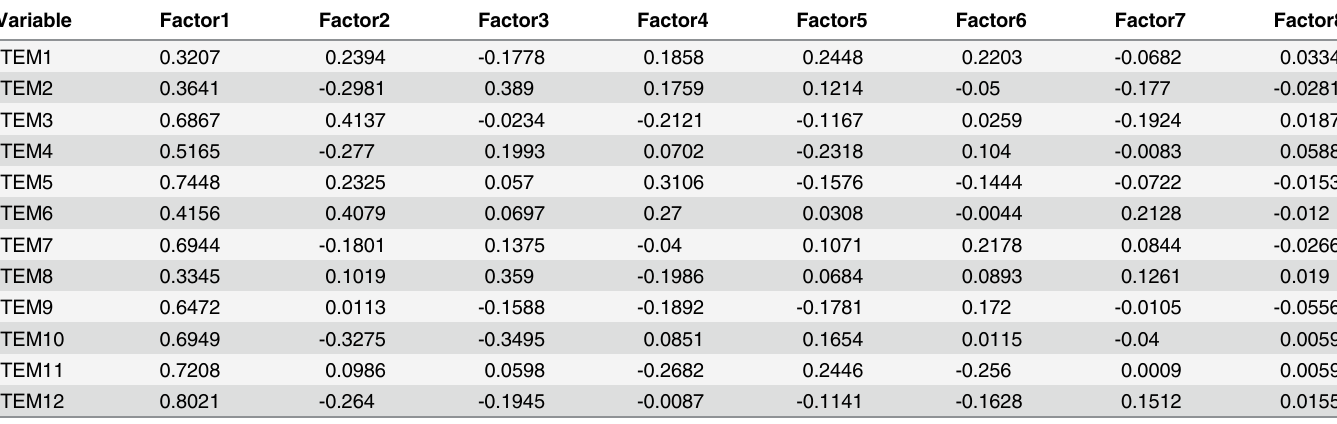
Only the factor loadings (represented as eigenvalue) greater than 1 were selected (Harman,